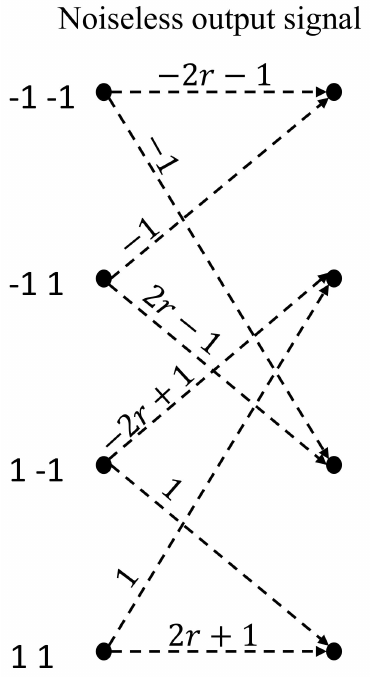
Figure 3. Trellis diagram for conventional Viterbi algorithm (VA).